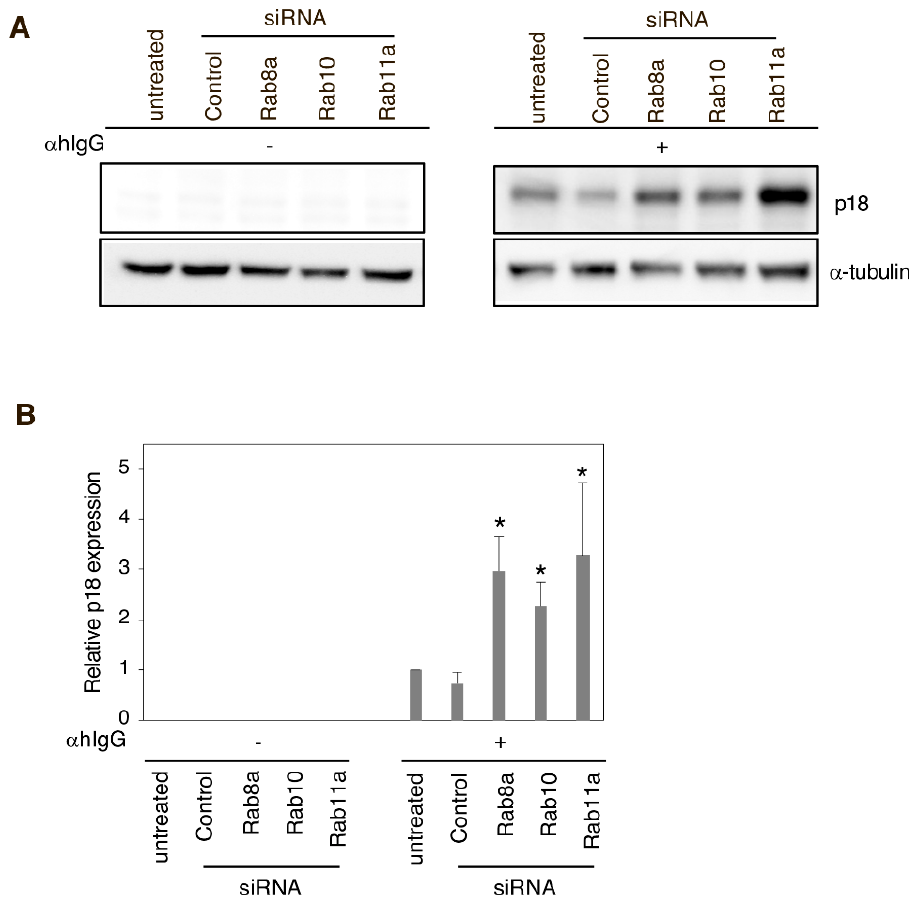
Figure 3. The e ff ect of Rab GTPase downregulation in EBV-encoded capsid antigen p18 expression. Rab8a, Rab10, and Rab11a were downregulated in Akata + cells using siRNAs. After 48 h of treatment with α hIgG for the EBV lytic cycle induction, and the semi-quantification of the EBV-encoded capsid, antigen p18 was performed by Western blot. ( A ) The representative data are shown. ( B ) Normalized p18 expression values to the reference α tubulin are shown. Results are representative of independent experiments conducted three times and the average and standard deviations values are shown. Statistical di ff erences were assessed using Student’s t test and are represented as * p < 0.05 versus respective control.